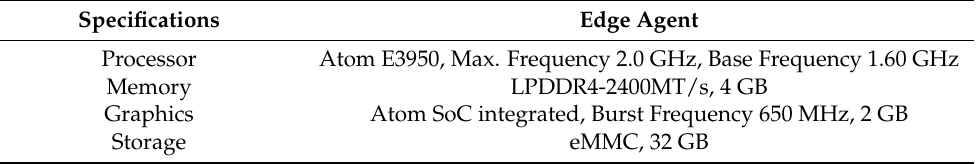
Table 1. Specification of edge agent in